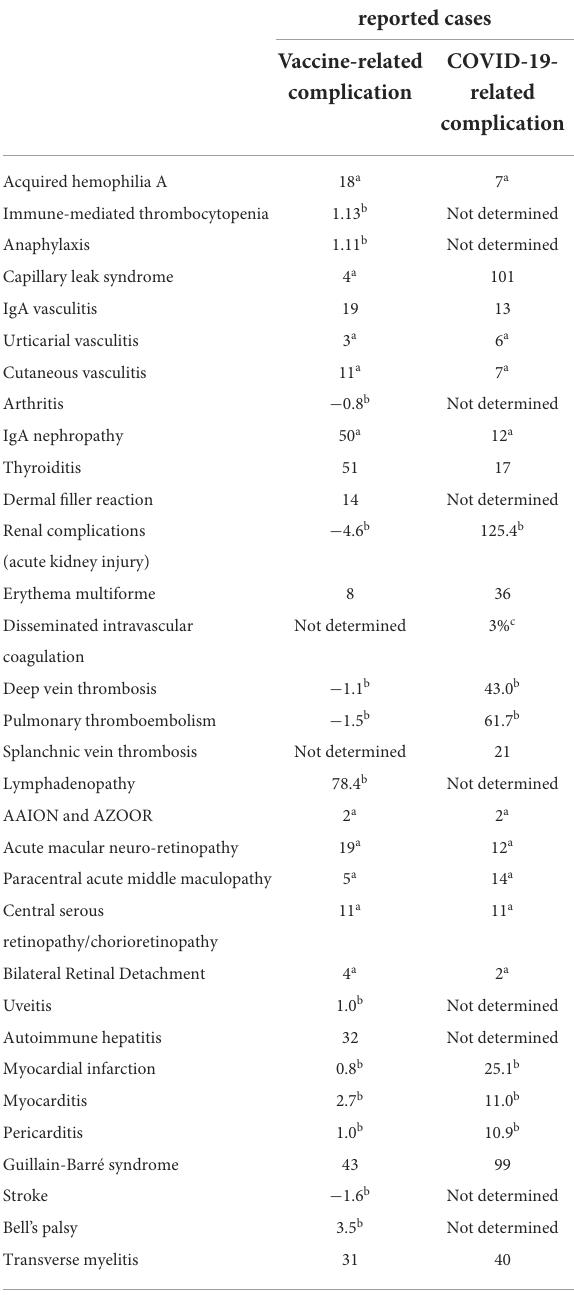
TABLE 1 Frequency of rare vaccine-related and COVID-19-related